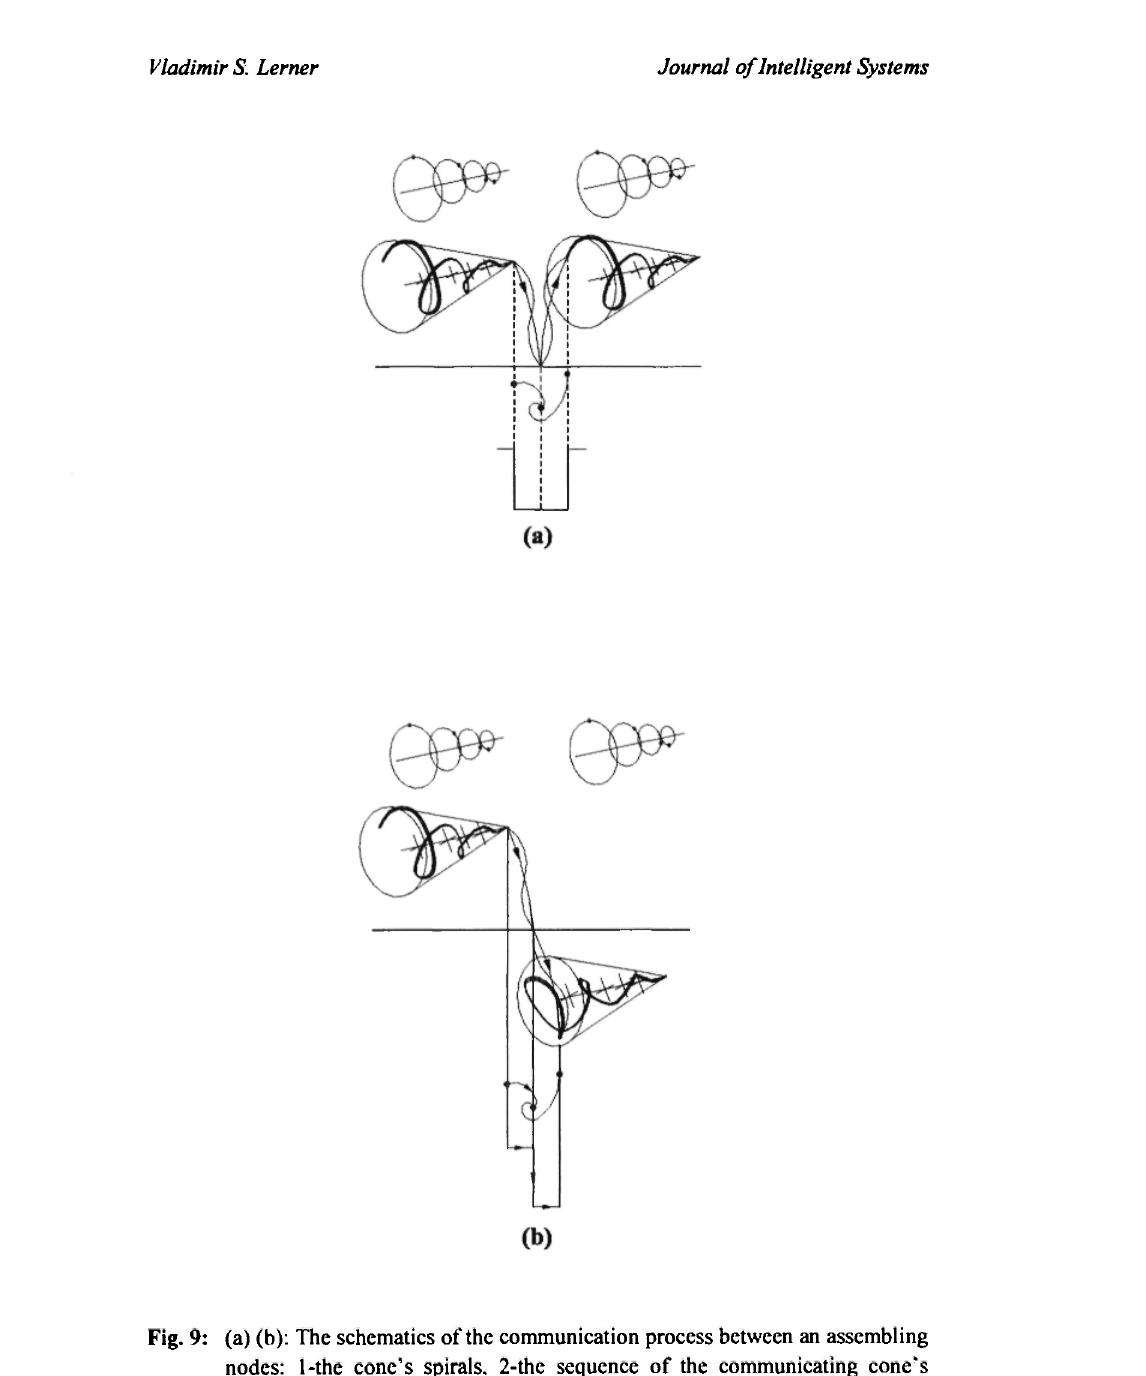
Fig. 9: (a) (b): The schematics of the communication process between an assembling nodes: 1-the cone's spirals. 2-the sequence of the communicating cone's cross sections F\(t]), F2U2) with the pieces of cone's spirals 3 on them.